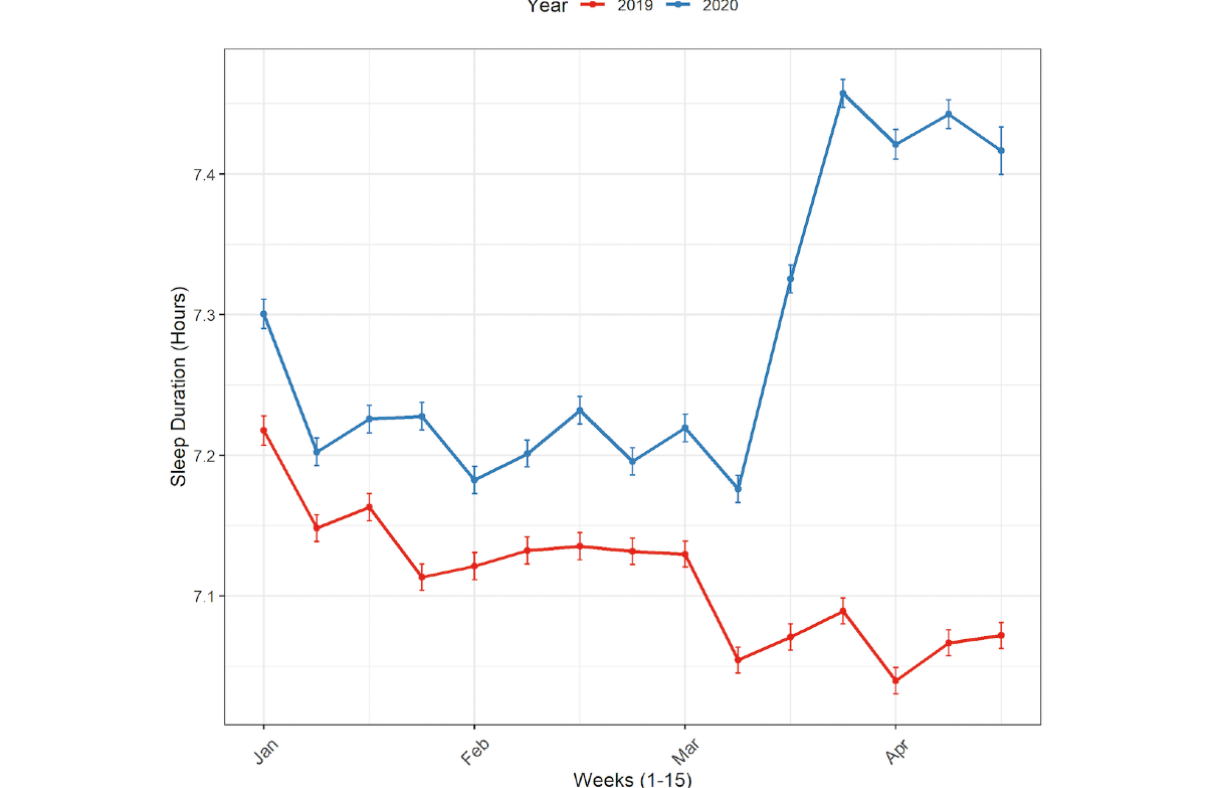
Figure 1. Estimated sleep duration by month (January to April) in 2019 and in 2020 for the total sample. The I-bars represent the 95% CIs.